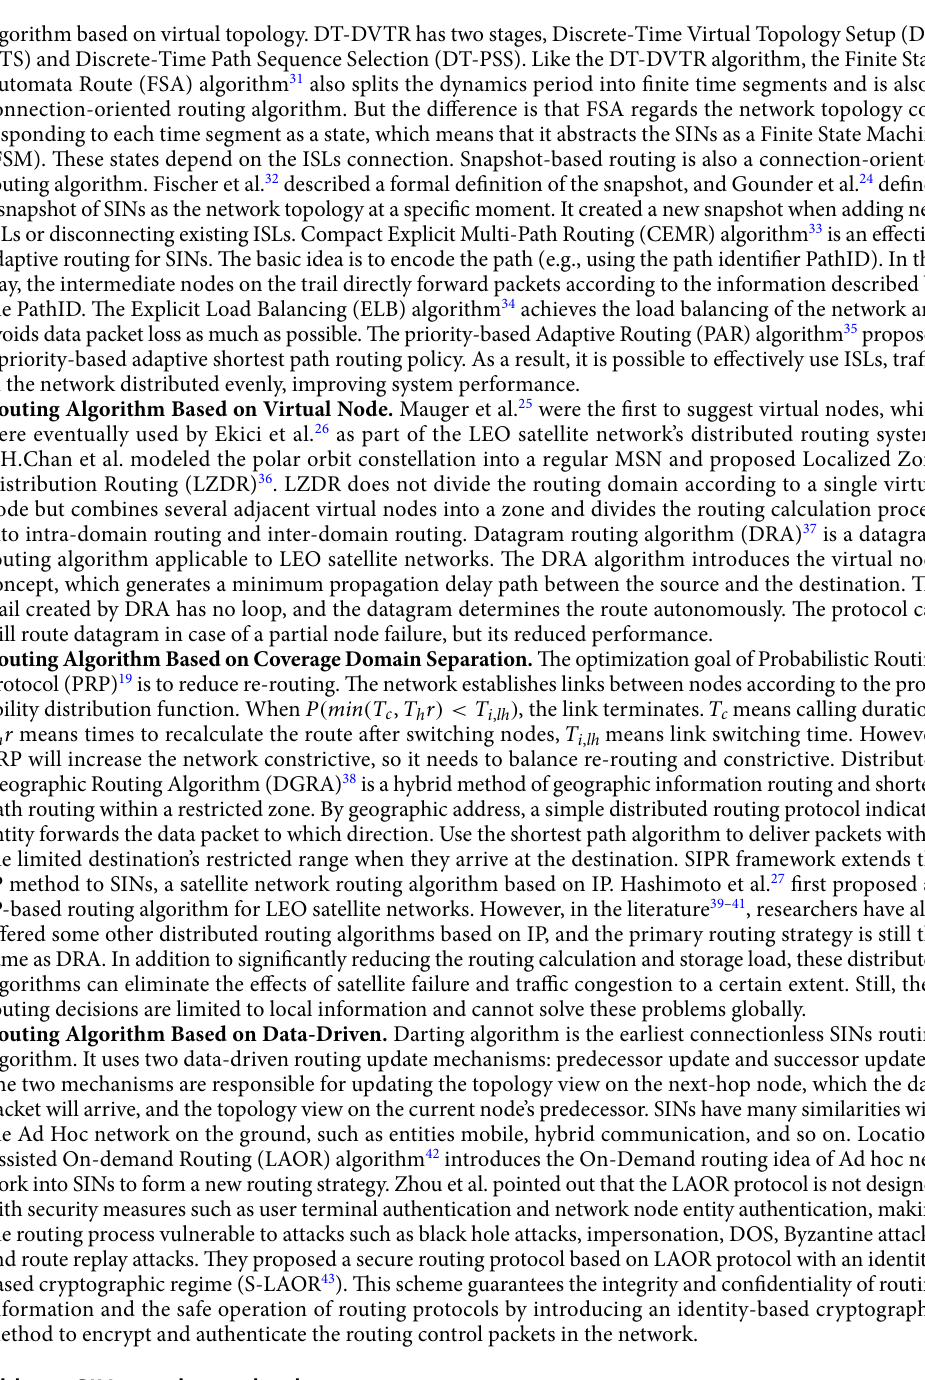
algorithm based on virtual topology. DT-DVTR has two stages, Discrete-Time Virtual Topology Setup (DT- VTS) and Discrete-Time Path Sequence Selection (DT-PSS). Like the DT-DVTR algorithm, the Finite